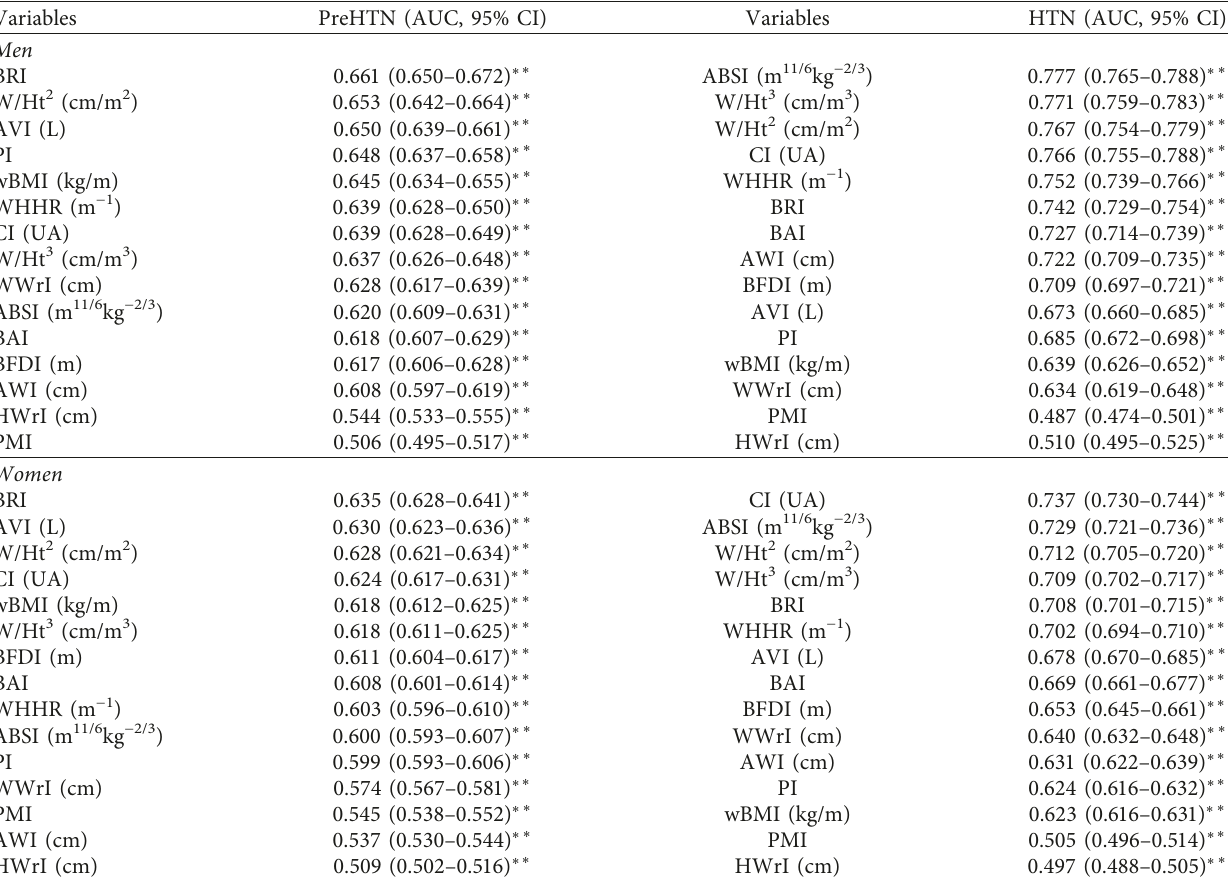
Table 3: Predictive value of the emergent anthropometric indices of preHTN and HTN according to